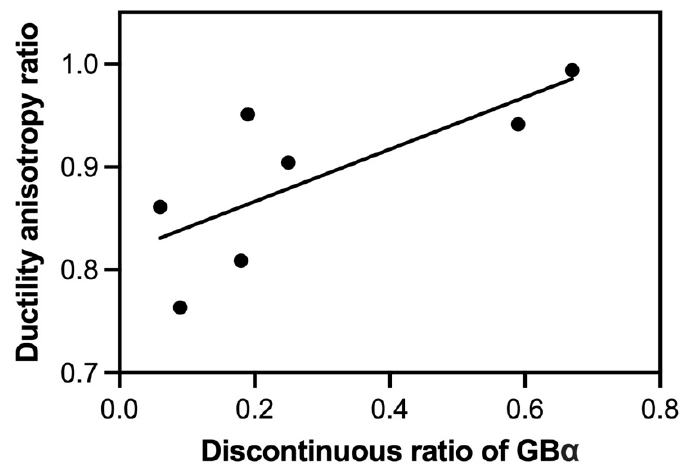
Figure 13. The relationship between the anisotropic ductility ratio (horizontal elongation/vertical elongation) and the discontinuous ratio of GB- α .